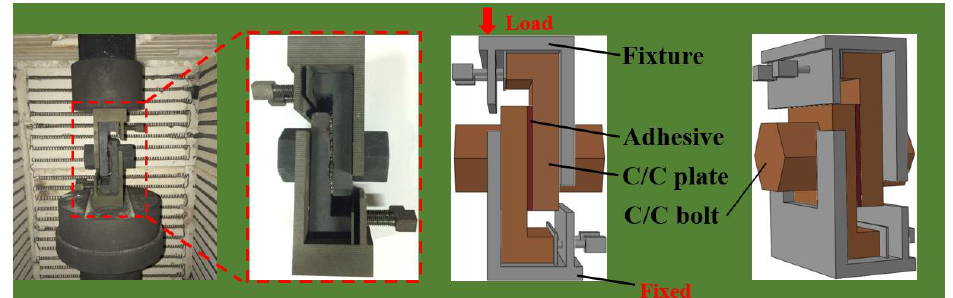
Figure 3. Fixture and loading method.